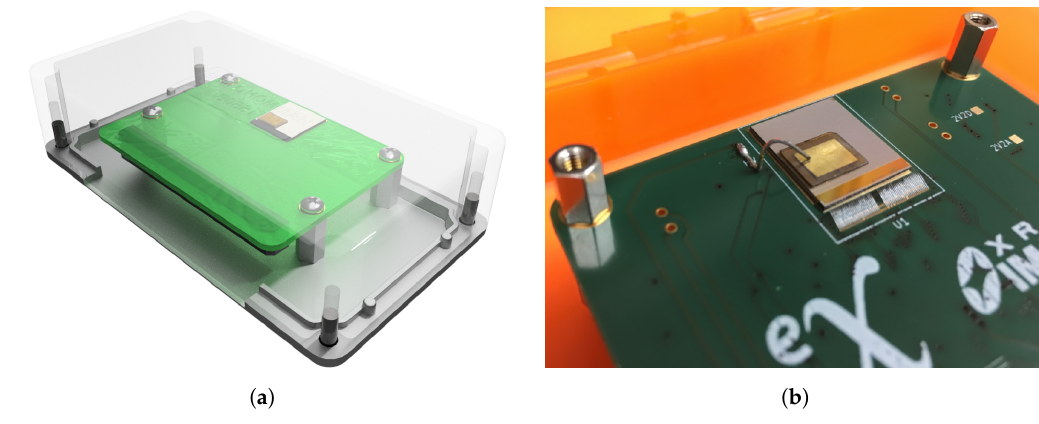
Figure 4. LISe semiconductor coupled to Timepix readout chip. ( a ) CAD model of LISe Timepix detection module; ( b ) bonded LISe Timepix imager PCB